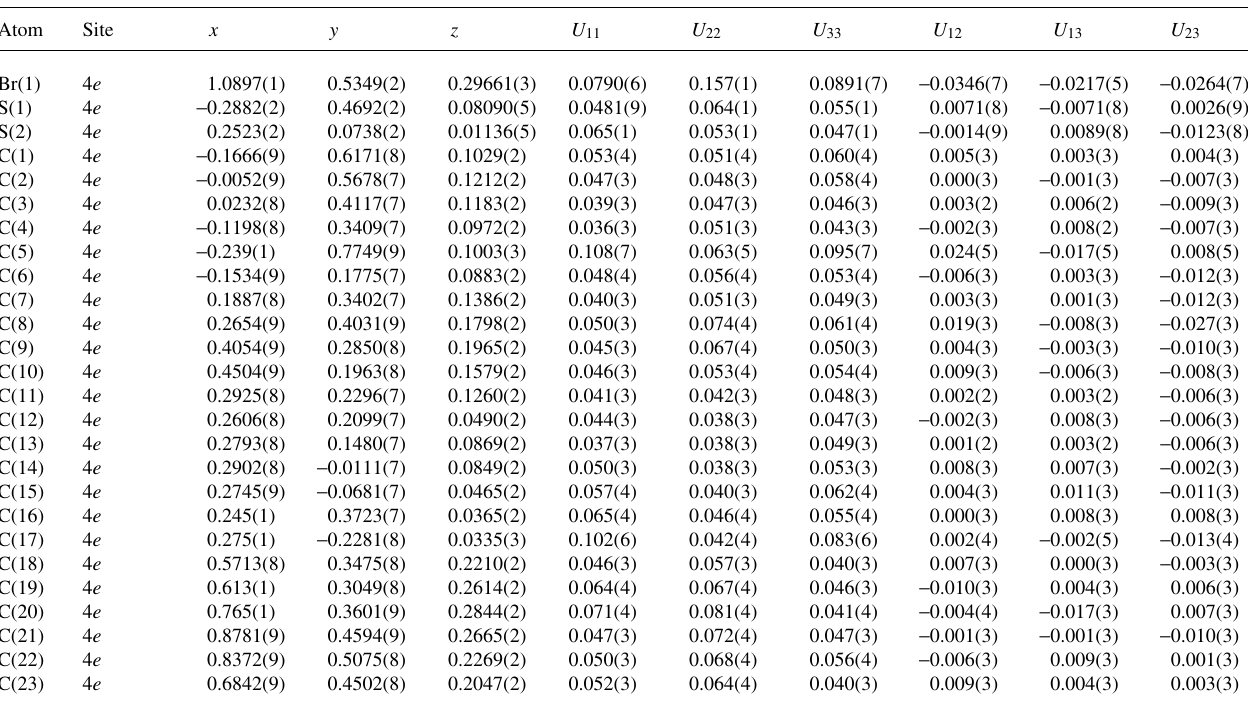
Table 3. Atomic coordinates and displacement parameters (in Å 2 ) .